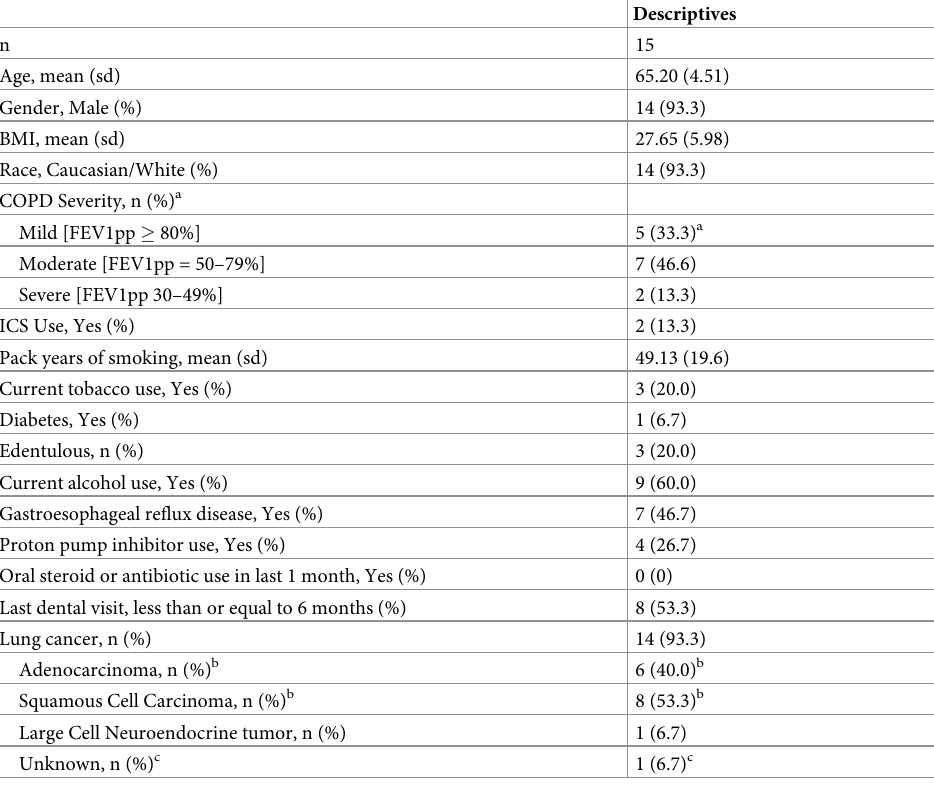
Table 1. Demographic and clinical characteristics of study